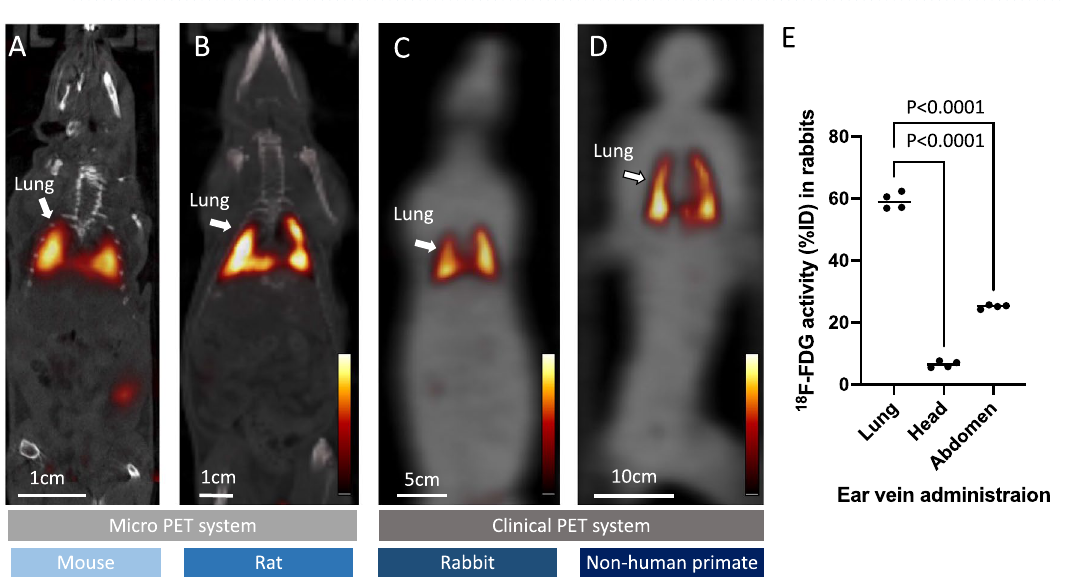
Figure 3. Representative whole body PET images after [18F]FDG labelled MSCs administration via peripheral vein in a mouse ( A ), rat ( B ), rabbit ( C ), and non-human primate ( D ). Images of the mouse and rat are fused with CT (gray scale) and rabbit and non-human primate are fused with transmission scan (gray scale). High radiotracer signal is seen in the lung of all tested animal species. Quantification of [18F]FDG distribution (%ID) in the lung, head, and abdomen area in rabbits ( E